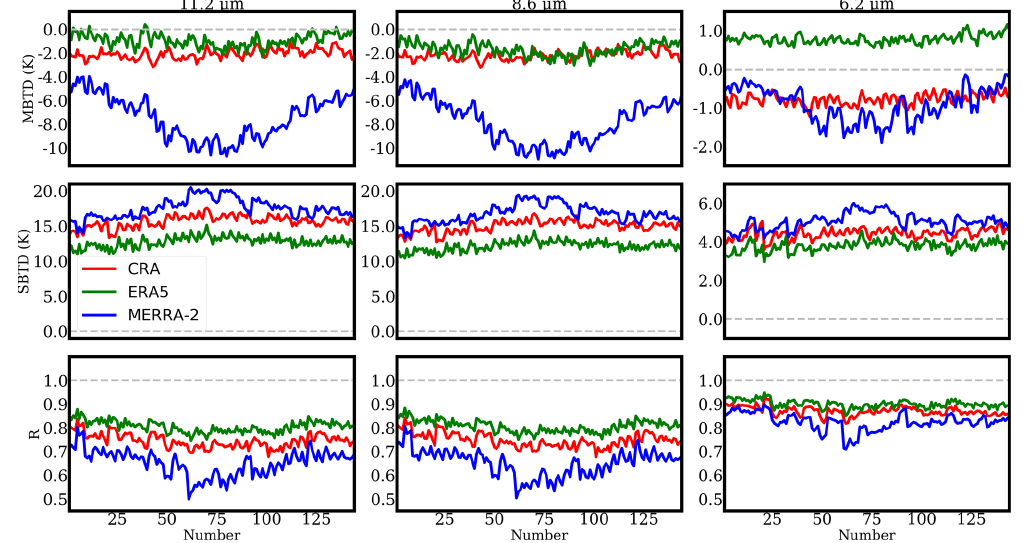
Figure 12. Temporal variation in three statistical parameters: mean BTDs (MBTDs), standard deviations of BTDs (SBTDs), and correlation coefficient ( R ) between the simulations and observations. The results are from 144 realizations spanning